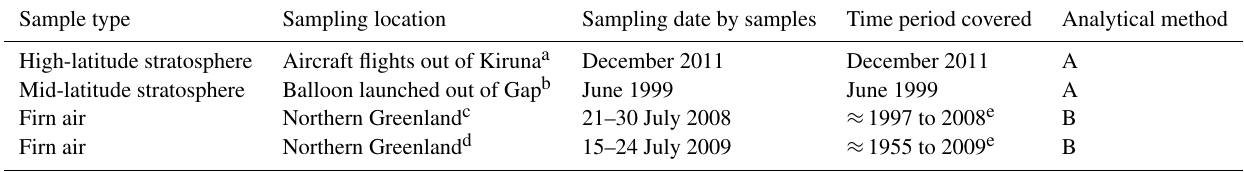
Table 1. Samples analysed in this study.